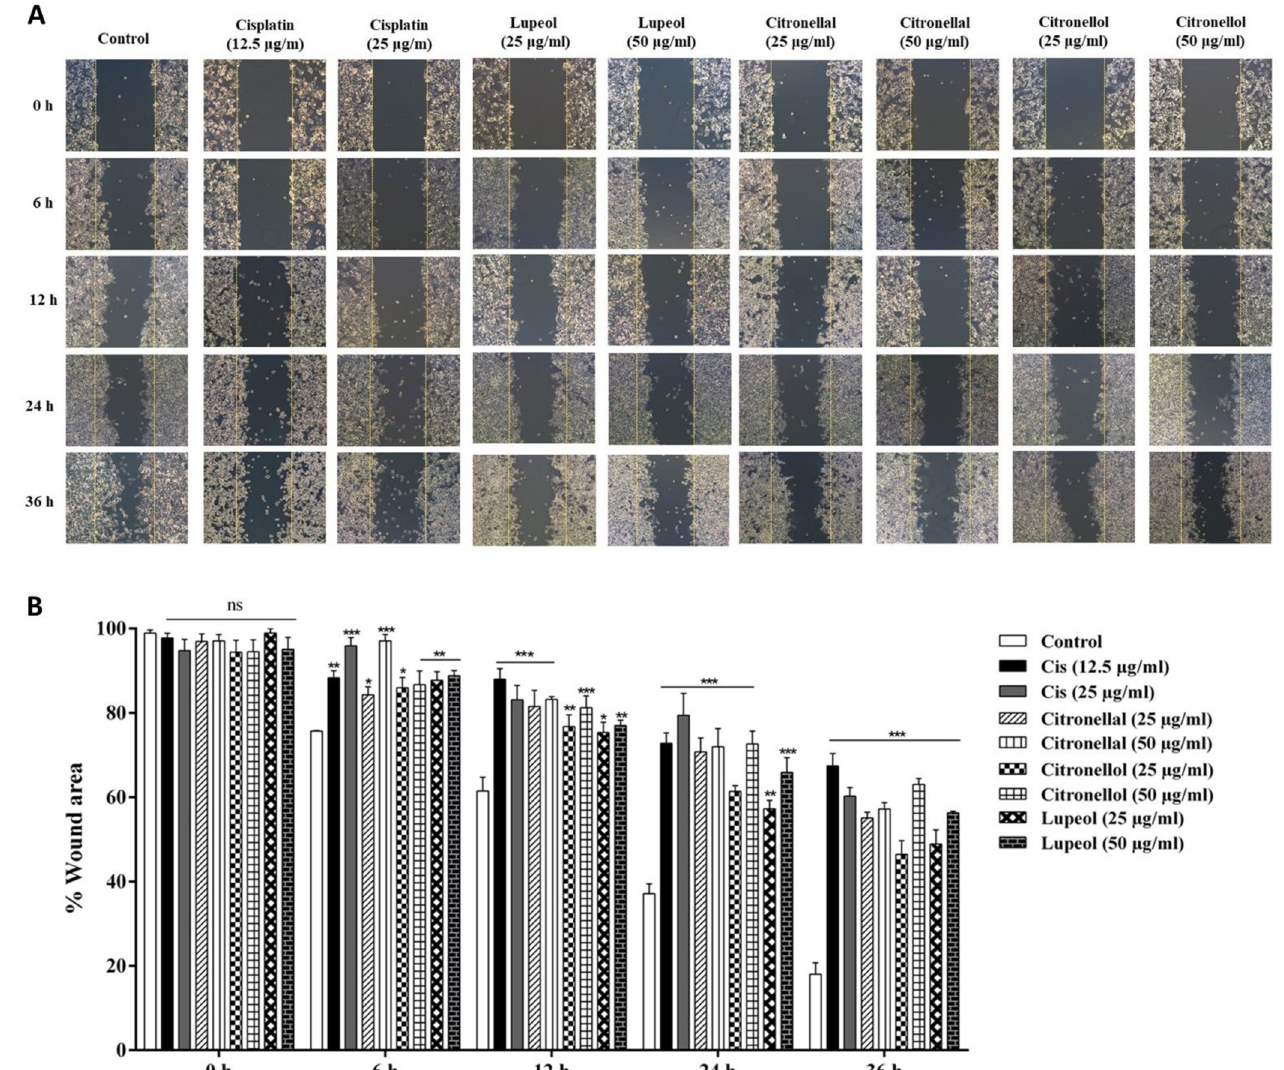
Fig 5. Cell motility assay of SCC15 cell line for untreated control and cells treated with crude extracts and their contained compounds for 36 hours. (A) Pictures of wound area taken at 0, 6, 12, 24 and 36 hours by an inverted microscope. (B) Distance of wound area measured using the ImageJ system. Percentage of wound area was calculated, with bar graphs representing means ± SEM. ns = not significant, � Statistically significant ( p � 0.05), �� p � 0.01 and ��� p � 0.001 compared to the control. KL H: Crude hexane; KL ET: Crude ethanolic